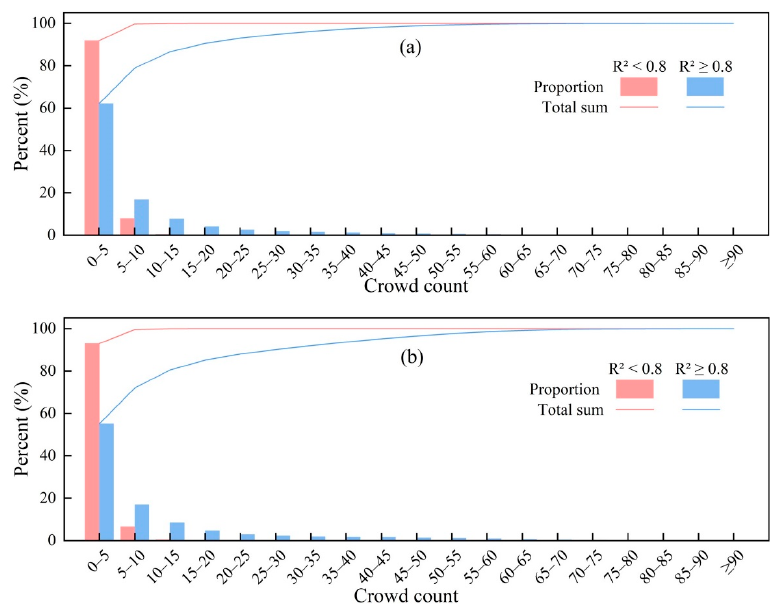
Figure 7. The interval distribution of datasets on ( a ) weekdays; ( b ) weekends.